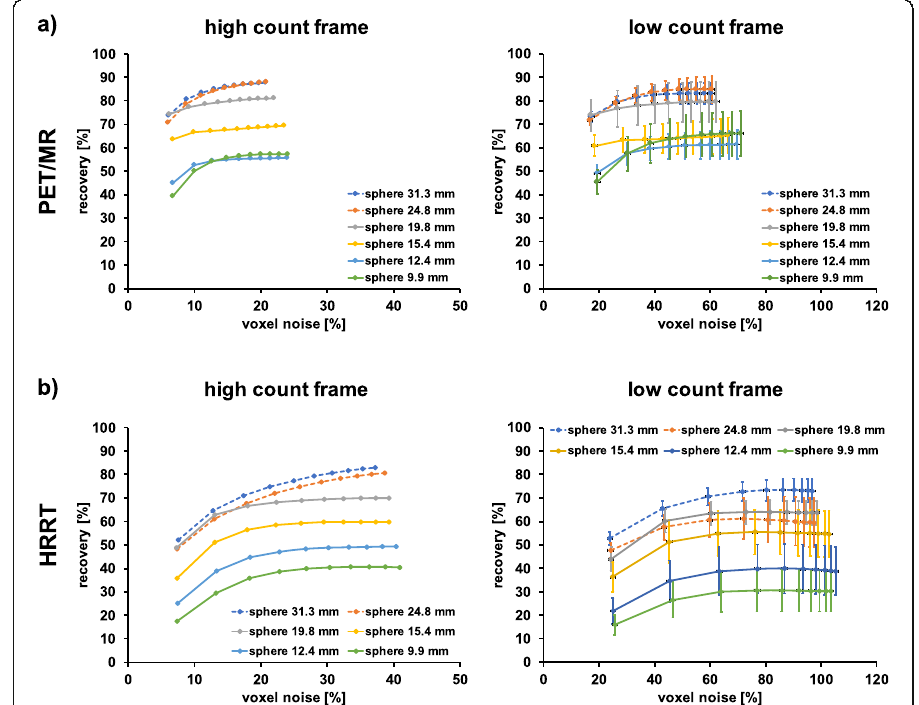
Fig. 5 RCs (%) as a function of voxel noise (%) for all sphere sizes for a high and low count frame for the contrast phantom (PET/MR ( a ), HRRT ( b )). The high count frame corresponds to ~ 135 million prompts within the frame, the low count frame to ~ 12 million prompts. Note the difference in x -axis limits. Each point represents an OSEM iteration, and the number of iterations increases from left to right. PET/MR data were reconstructed with TOF + PSF + filter; HRRT data were reconstructed with filter only (standard in- house reconstruction for human data). High count data were analyzed based on a single realization while low count data were based on five replicates. Solid lines represent the hot spheres, dotted lines the cold